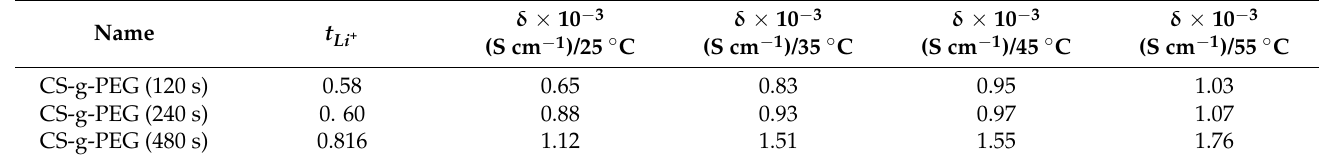
Table 2. Lithium ion transport numbers and ionic conductivities of CS-g-PEG.